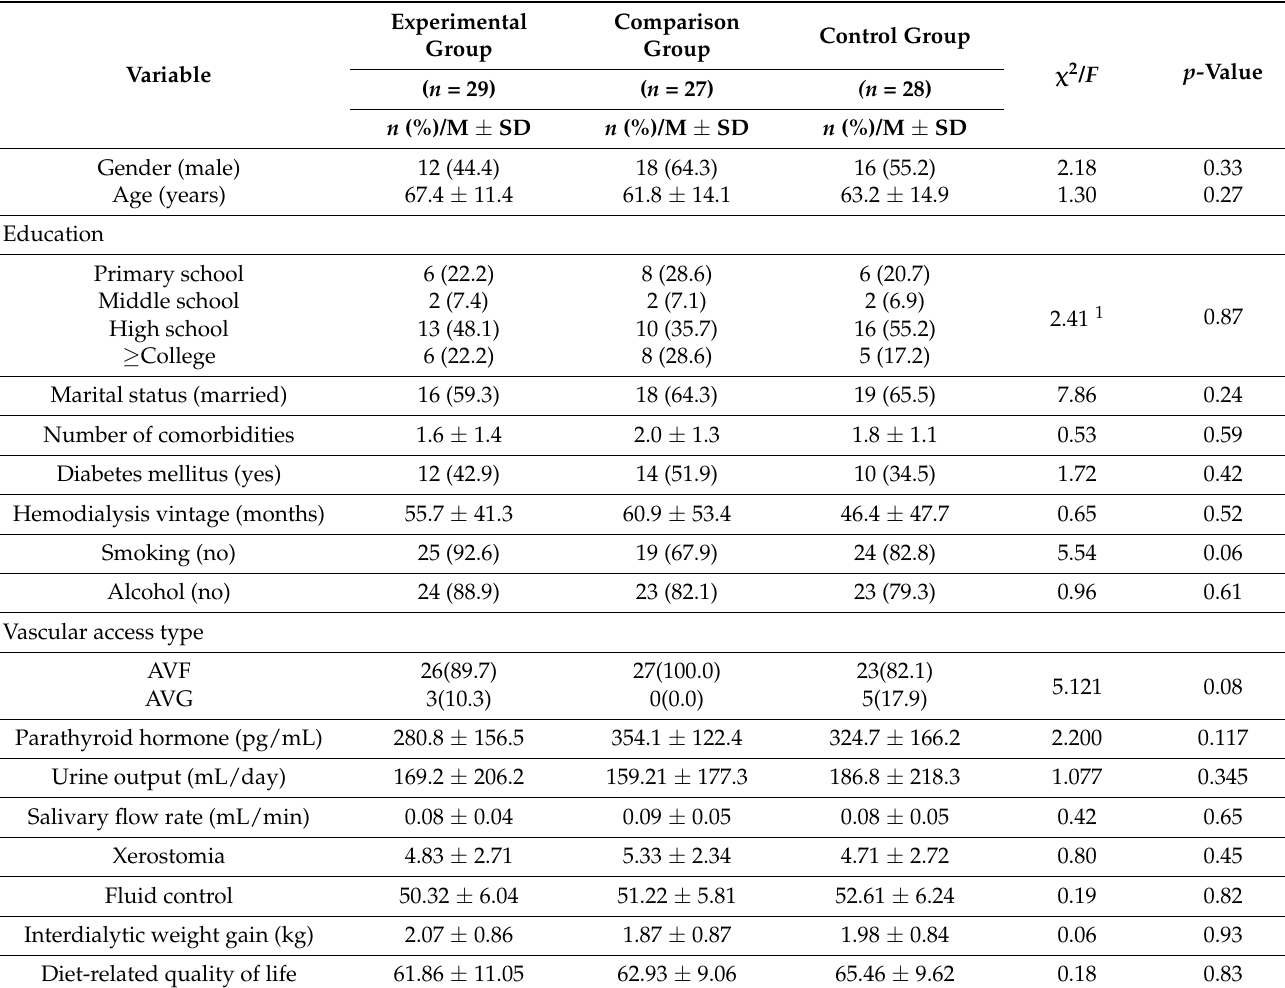
Table 1. Comparison of participants’ demographics and outcome variables ( n =